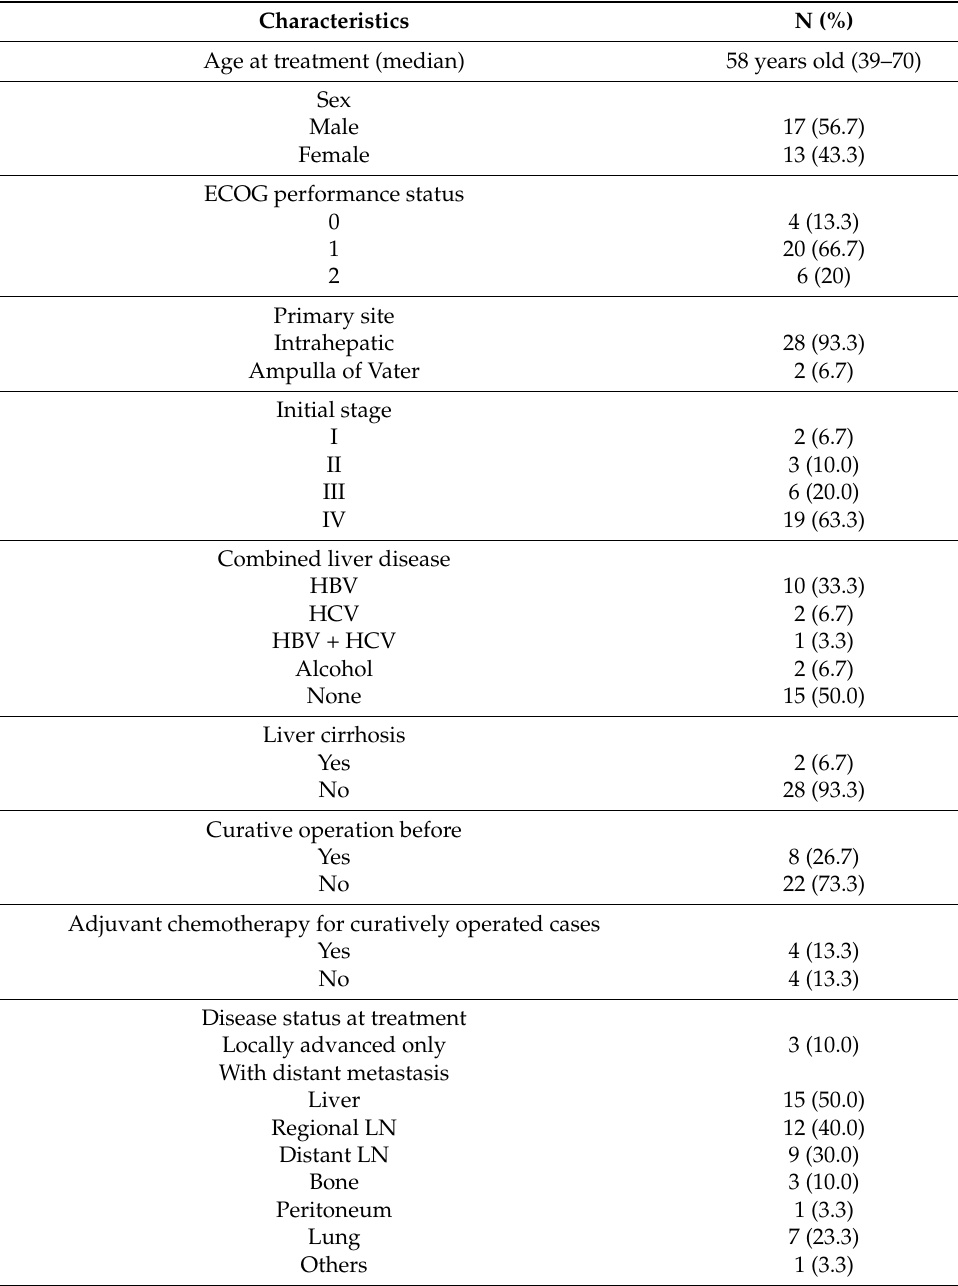
Table 1. Clinical characteristics of patients at